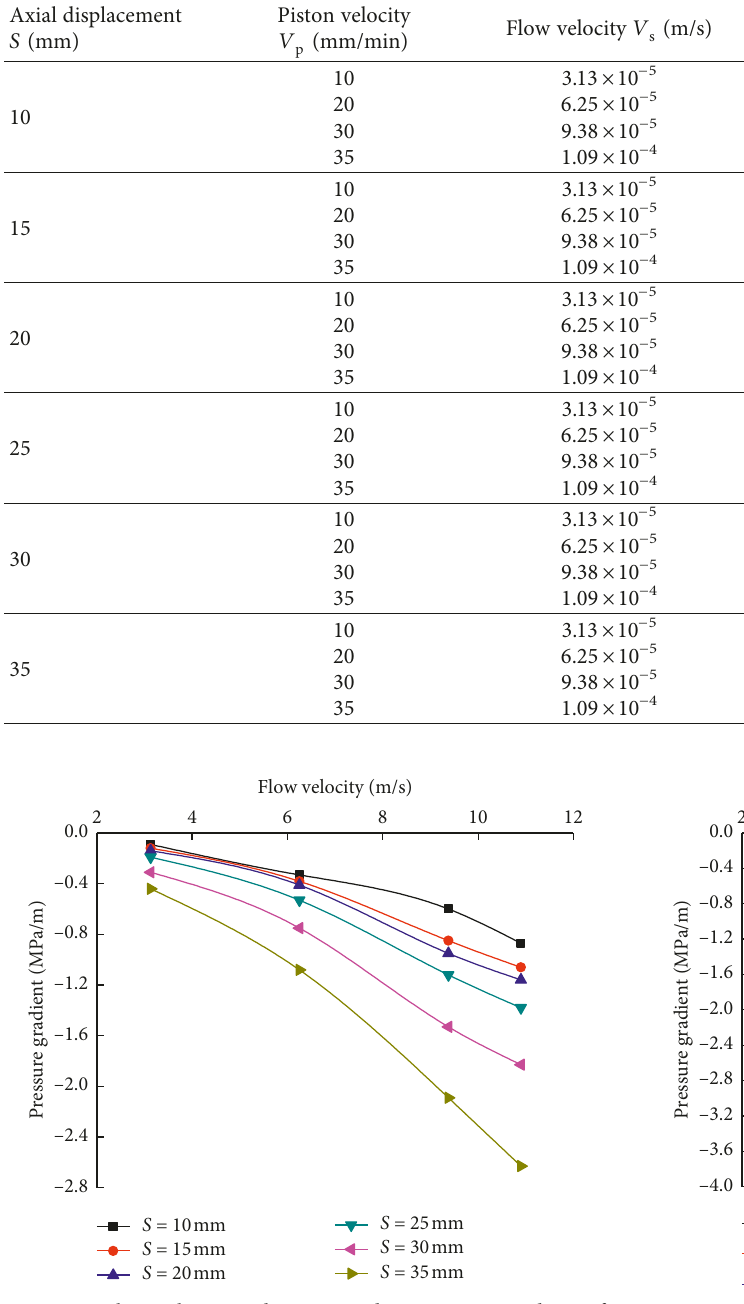
Figure 6: Flow velocity and corresponding pressure gradient of all the specimens when the axial displacement is 10